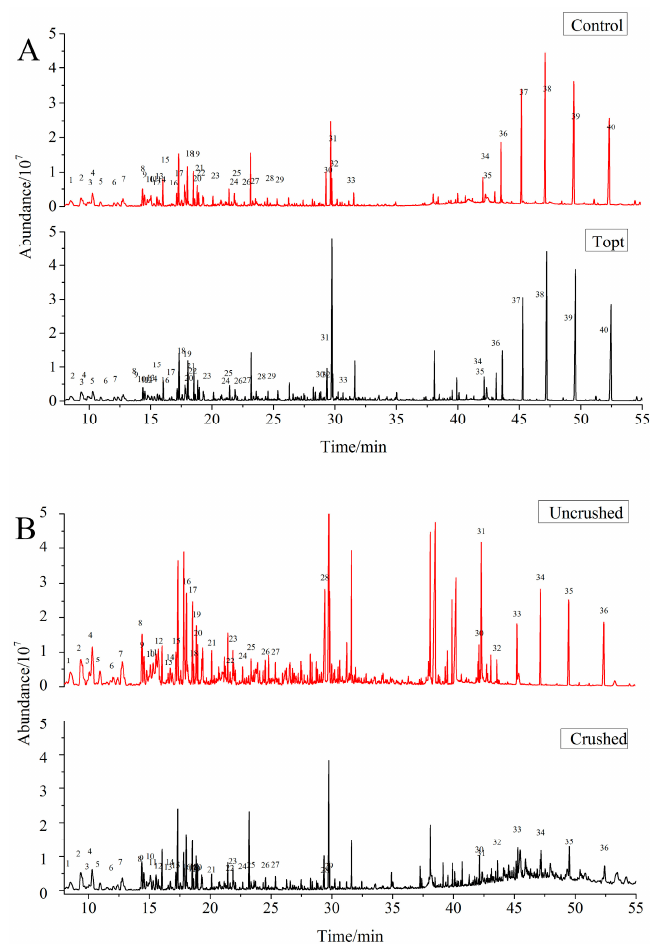
Figure 3. Total ion chromatograms of aroma composition of the intact and crushed tea leaves after subcritical butane processing. A : the intact tea leaves, including the control sample and Topt sample (the treated sample), which was treated by the SBE processing under the optimum condition: extraction temperature 45 ◦ C, extraction time 30 min, number of extraction cycles 1. B : the crushed and uncrushed tea leaves were processed by SBE under the condition numbered 3. The number in the figure represents the number for every substance.